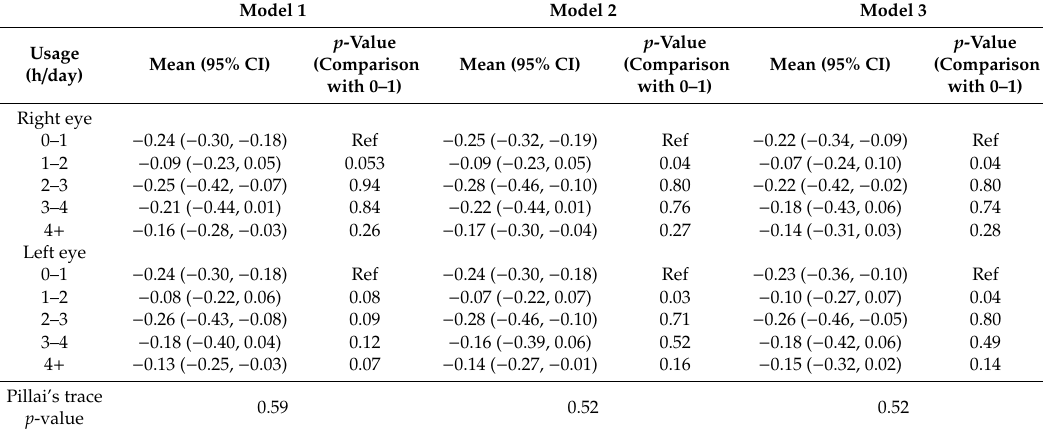
Table 4. Multivariate regression of tablet usage (hours per day) on 1-year change in spherical equivalent refraction (SER), imputed